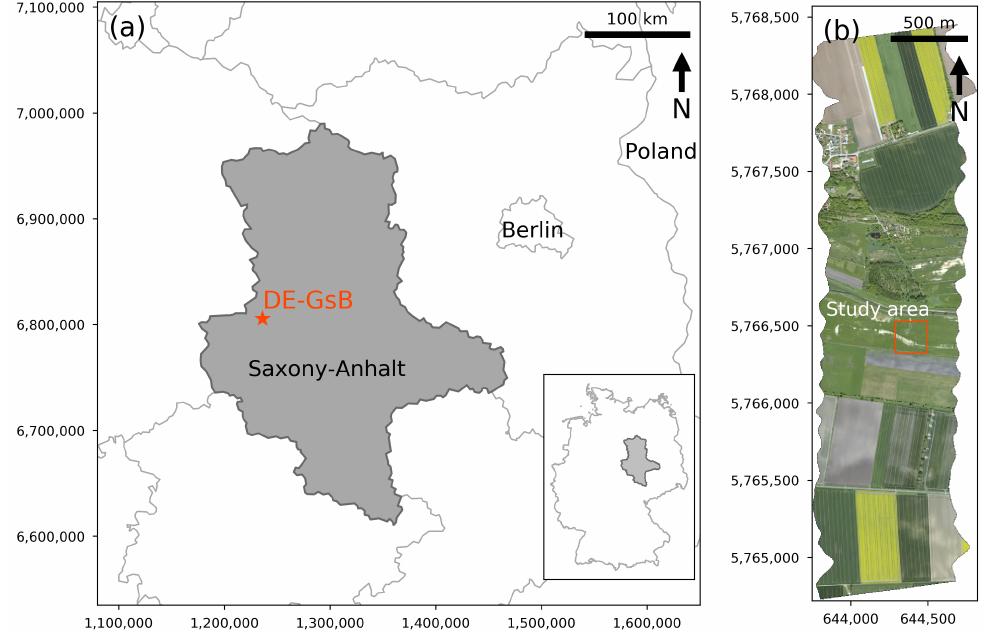
Figure 1. ( a ) Location of the research site “Am Grossen Bruch” (DE-GsB) within Germany (CRS: EPSG:3857). ( b ) RGB representation of the 2018 hyperspectral flight strip showing the surroundings of the study area (CRS: